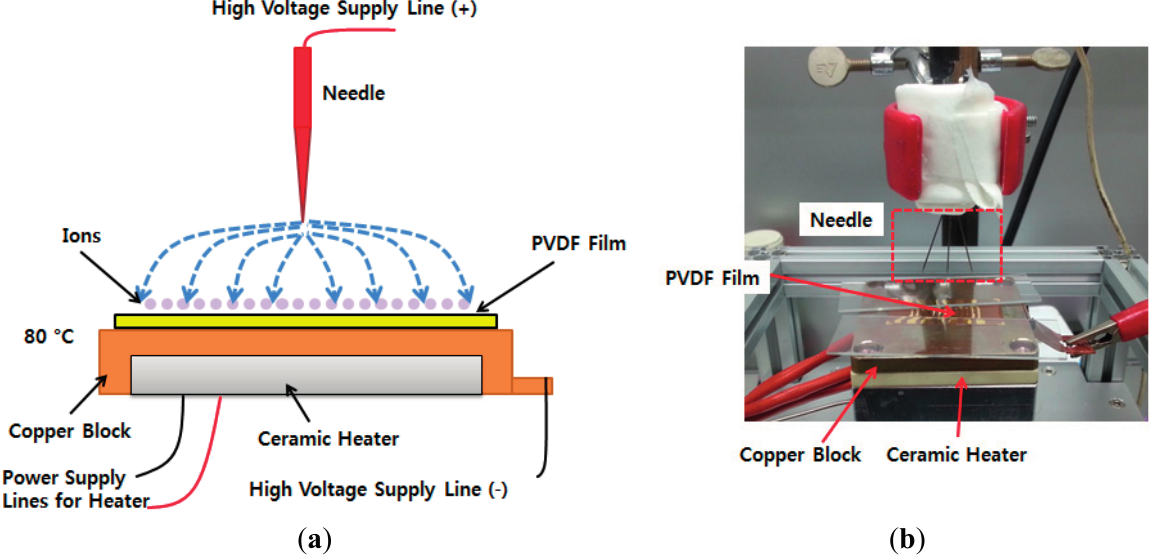
Figure 6. Schematic diagram of corona poling device ( a ); setup of corona poling device ( b ).